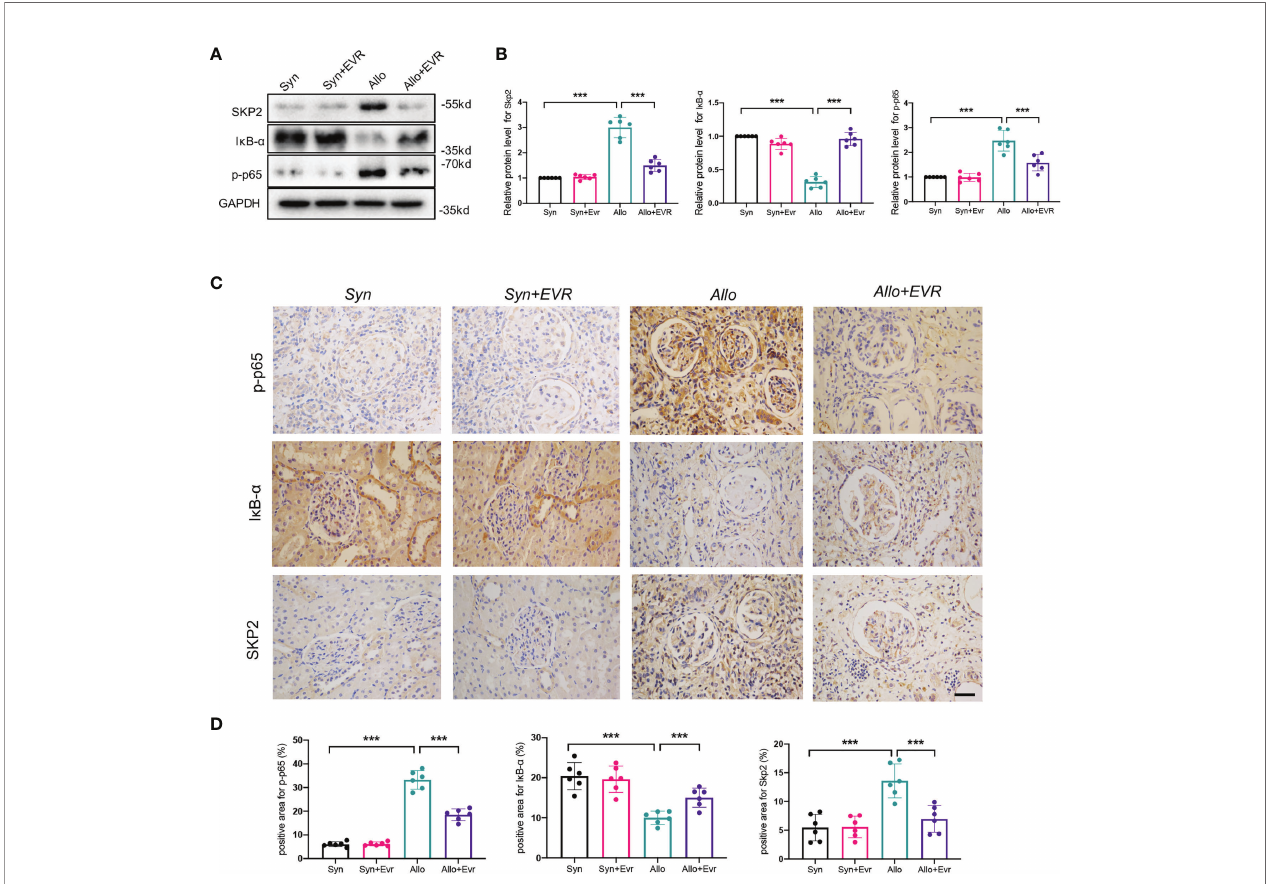
FIGURE 8 | EVR upregulated I k B- a protein and downregulated Skp2 and p-p65 in the CAD rat model. (A) Representative Western blotting results of Skp2, I k B- a , and p-p65 in kidney tissues from different treatment group rats. (B) Semi-quantitative analyses results of relative protein abundances of Skp2, I k B- a , and p-p65 in kidney tissues from different treatment group rats. Values represented the mean ± SD ( n = 6, *** p < 0.001). (C) Representative IHC images of Skp2, I k B- a , and p- p65 in kidney sections from different treatment group rats (scale bar: 10 m m). (D) Semi-quantitative analyses results of IHC positive staining of Skp2, I k B- a , and p- p65 in kidney sections from different treatment group rats. Values represented the mean ± SD ( n = 6, *** p <